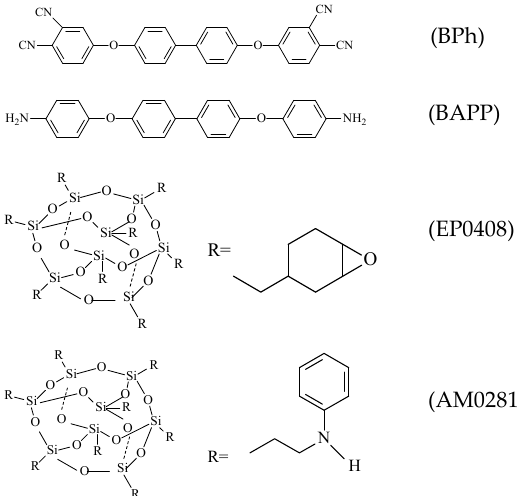
Figure 1. Structures of the phthalonitrile monomer, curing agent, and the two types of phthalonitrile–polyhedral oligomeric silsesquioxane (POSS) used herein.